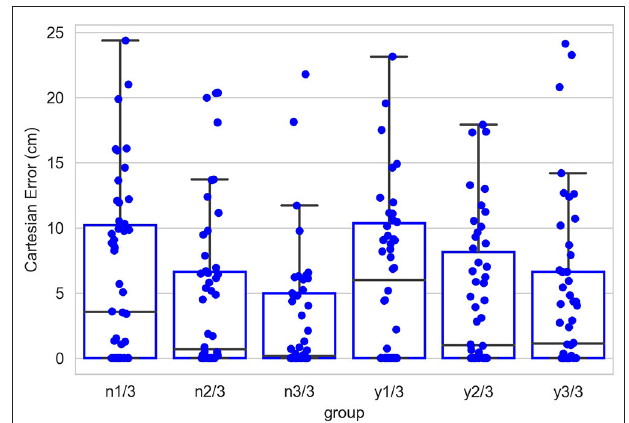
FIGURE 12 | Cartesian errors in all six conditions. Along the vertical axis, “n” means results are obtained under the condition without noise applied to joints, “y” means noisy, and the fractions after n or y show the proportion of the entire learning session experienced after which test results are obtained. Within the chart, each box contains three black bars and a box body marks two levels by upper and lower edges. From up to down, these five levels indicate the maximum, third quarter (Q3), median, first quarter (Q1) and minimum values of the value set represented, which is called “five-number summary.” Points that